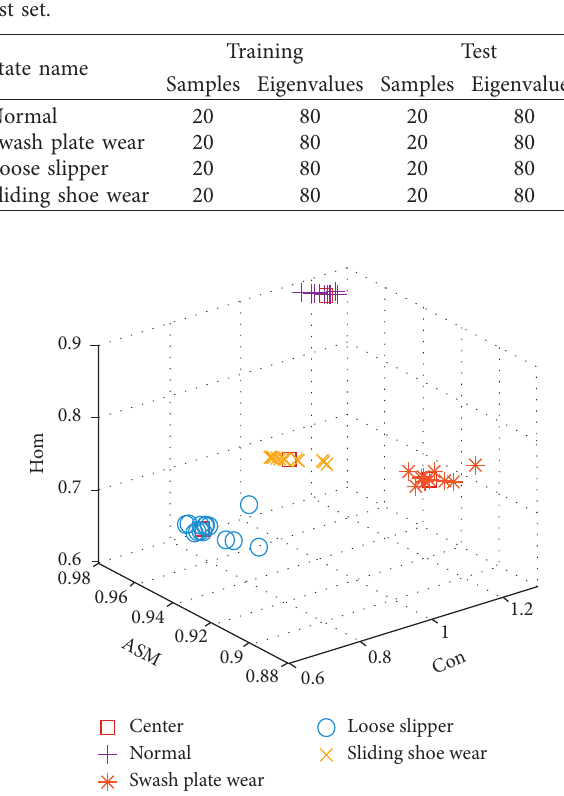
Figure 19: Clustering results of symmetrical polar coordinate combined with GLCM.